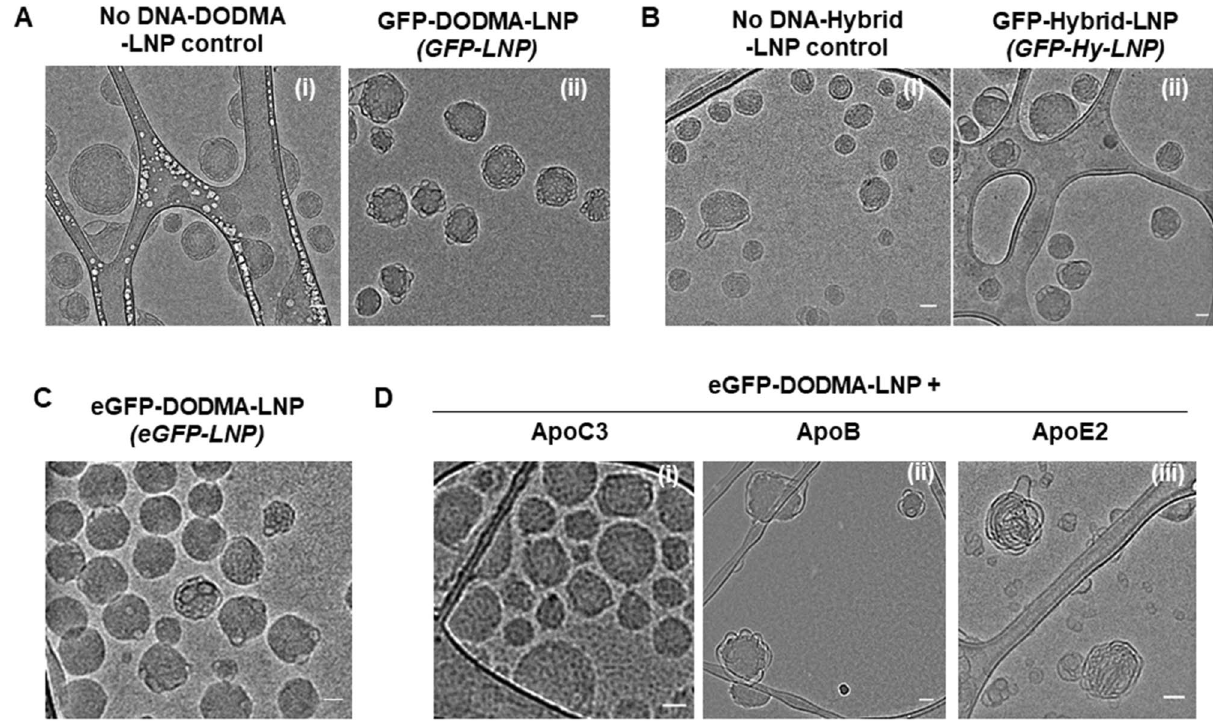
Figure 1. Cryo-TEM analysis of LNPs. ( A ) Cryo TEM analysis of No DNA-DODMA-LNP control ( A-i ) or GFP-DODMA-LNP ( A-ii ), No DNA-Hybrid-LNP control ( B-i ) or GFP-Hybrid-LNP ( B-ii ) and eGFP- DODMA-LNP ( C ). 5 µg plasmid equivalent eGFP-DODMA-LNPs were incubated with 3 µg ApoC3 ( D-i ), ApoB ( D-ii ) and ApoE2 ( D-iii ) overnight at 4 °C followed by Cryo-TEM analysis. Scale bar represents 50